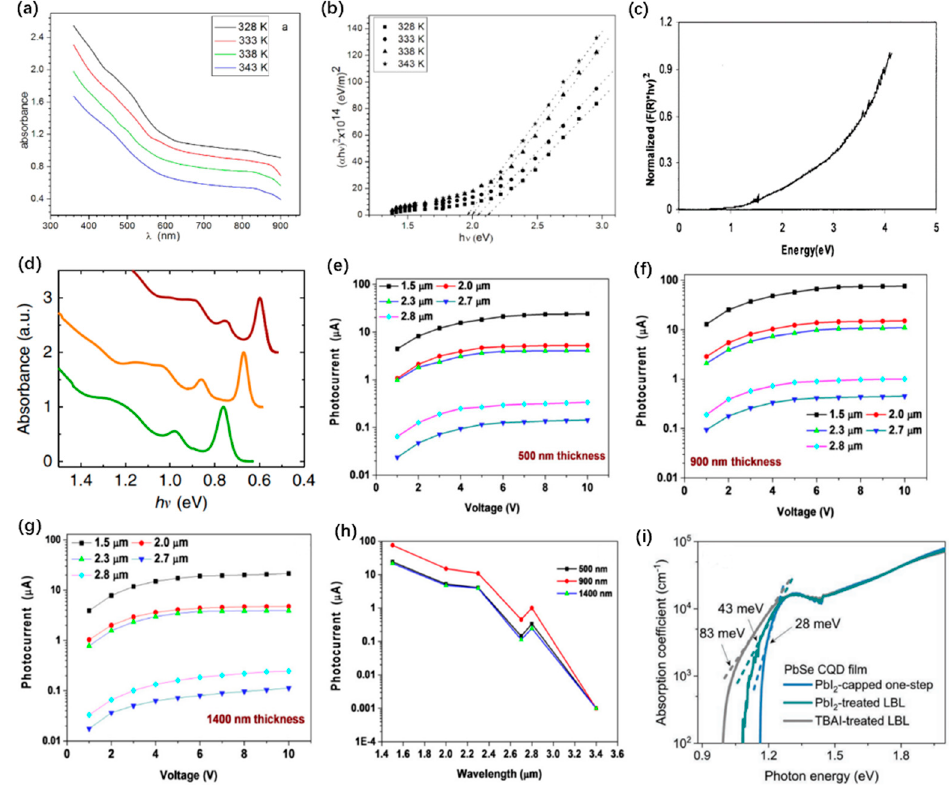
Figure 4. ( a ) UV absorption spectra of PbSe thin films reported by Anayara et al. Reprinted with